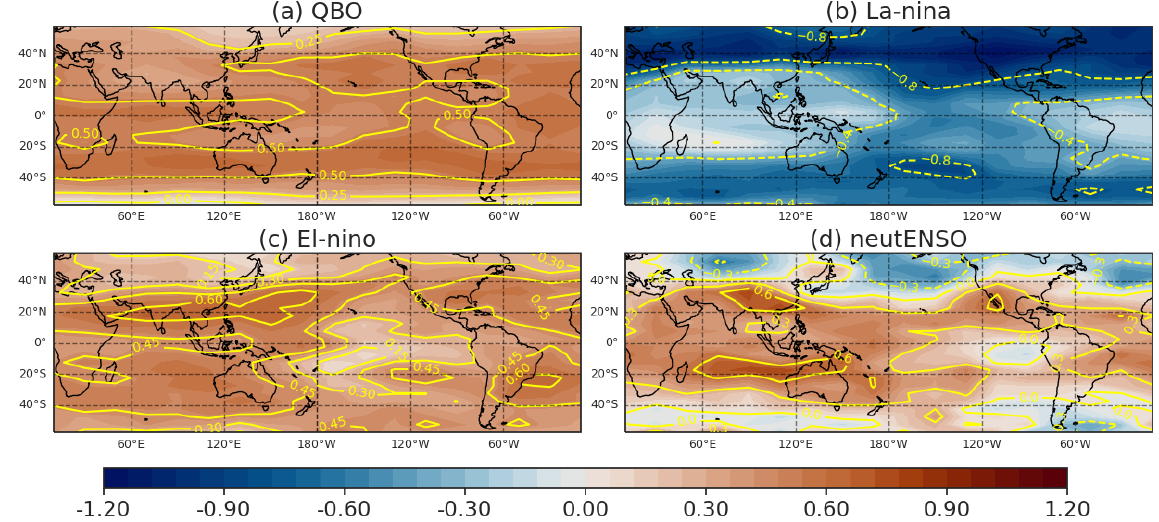
Figure 7. The in-sample β coefficients for the MLR analysis of water vapor at the 82.54hPa level from 2005 to 2019. The ENSO predictor was separated into three parts, where EN represents the El Niño events (ENSO ≥ 0.5), LN represents the La Niña events (ENSO ≤− 0 . 5) and neutENSO the rest of the ENSO